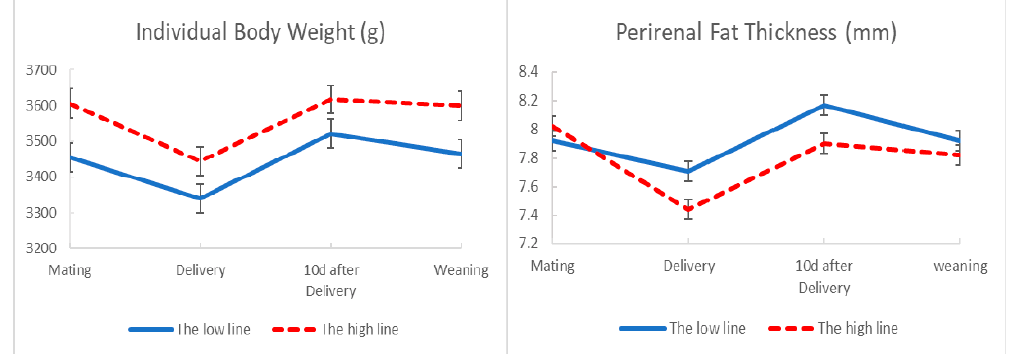
Figure 1. Development of individual body weight and perirenal fat thickness at second mating, delivery, 10 days after delivery and weaning in the low and high lines. The bars show standard